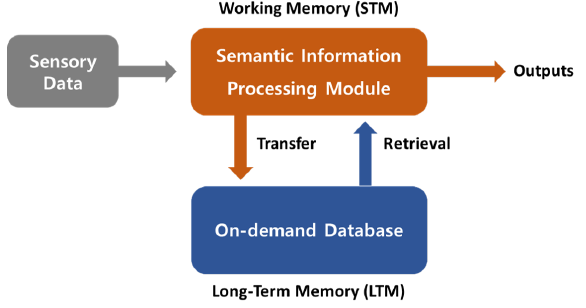
Figure 5. Human-like memory